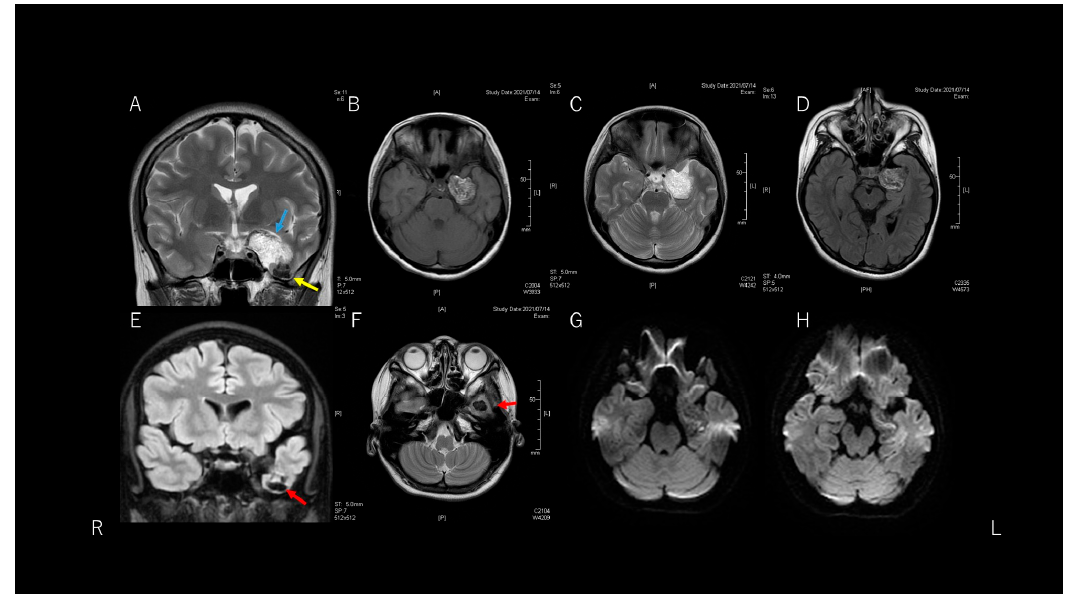
Figure 2. A lesion is evident in the left temporal fossa. This lesion consists of two components, indicated by sky blue and yellow arrows ( A ). Axial T1-weighted imaging (WI) and T2-WI ( B , C ) show heterogeneous and hyperintense parts, respectively. Since a thin space exists between the lesion and temporal lobe structures, this component is considered an extra-axial lesion. This component is displacing the temporal lobe and hippocampus ( D ). The other component is located within the temporal lobe, appearing as a low-intensity cystic lesion ( E , F : red arrows). Diffusion WI ( G , H ) shows heterogeneous, slightly hyperintense findings.